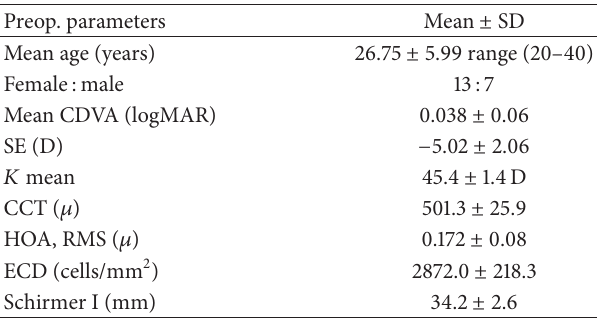
Table 1: Preoperative data ( 𝑛 = 40 eyes) who underwent SMILE